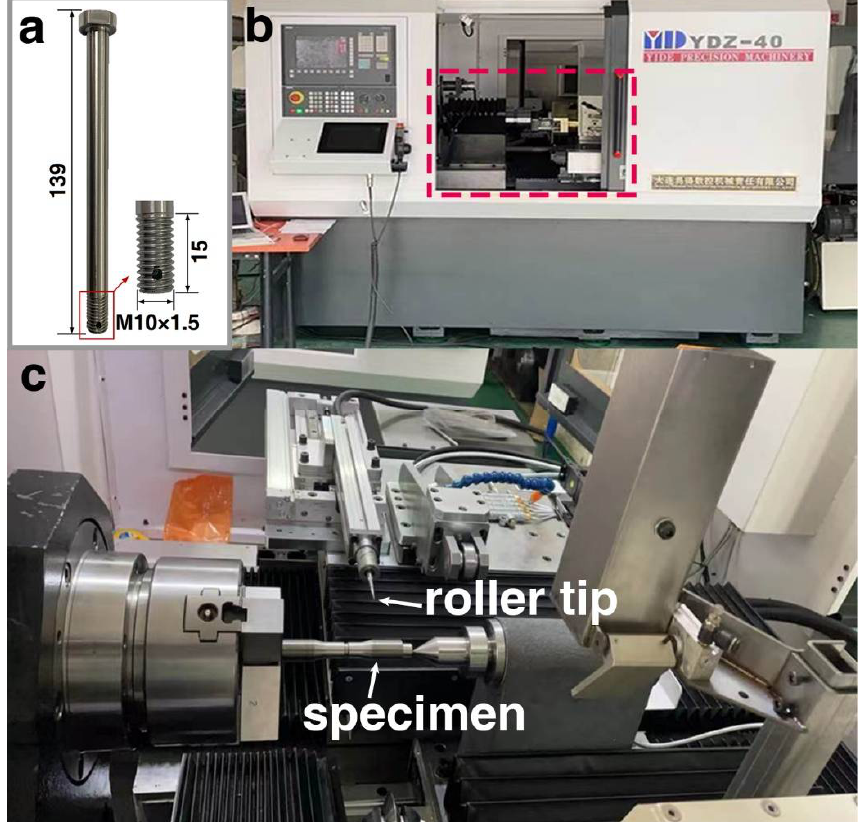
Figure 1. The bolts ( a ), apparatus ( b ) and its innards ( c ) used for deep rolling in this